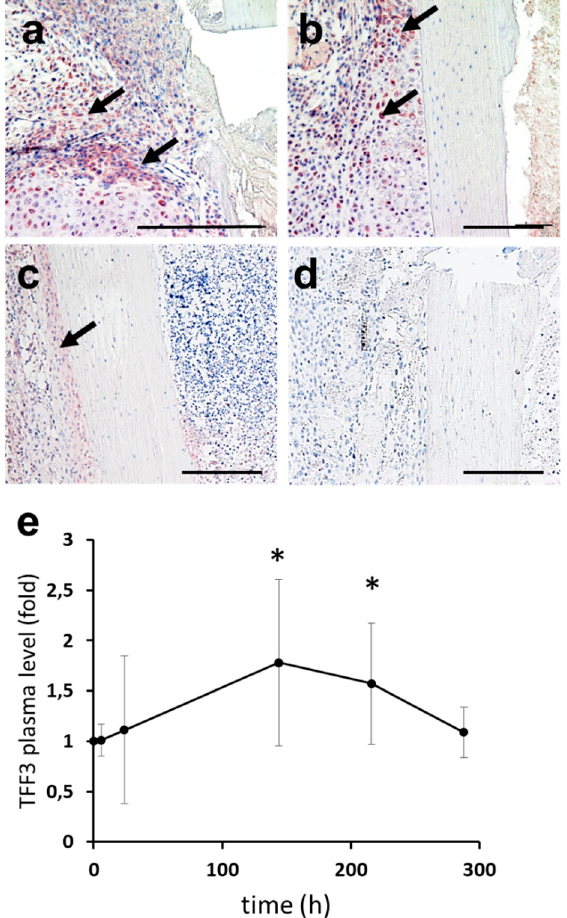
Figure 2. Expression of TFF3 under pathological conditions. Immunoreactivity for TFF3 10 days following defined fracture of the femur in a murine model. Positive TFF3 reactivity in soft callus ( a ) and cartilaginous callus ( b ) (arrows). Osteocytes of cortical bone and hematopoietic cells within bone marrow in healthy areas largely lack TFF3 reactivity, whereas periosteal cells are characterized by distinct TFF3 immunoreactivity (arrow) ( c ). Negative control ( d ). ELISA analysis reveals a significant increase of serum TFF3 at six and nine days following total knee replacement ( e ). The graphs show the mean ± SD expression levels of TFF3 (normalized to β 2-microglobulin) in samples from three different donors. * p < 0.05. bars = 100 µm.